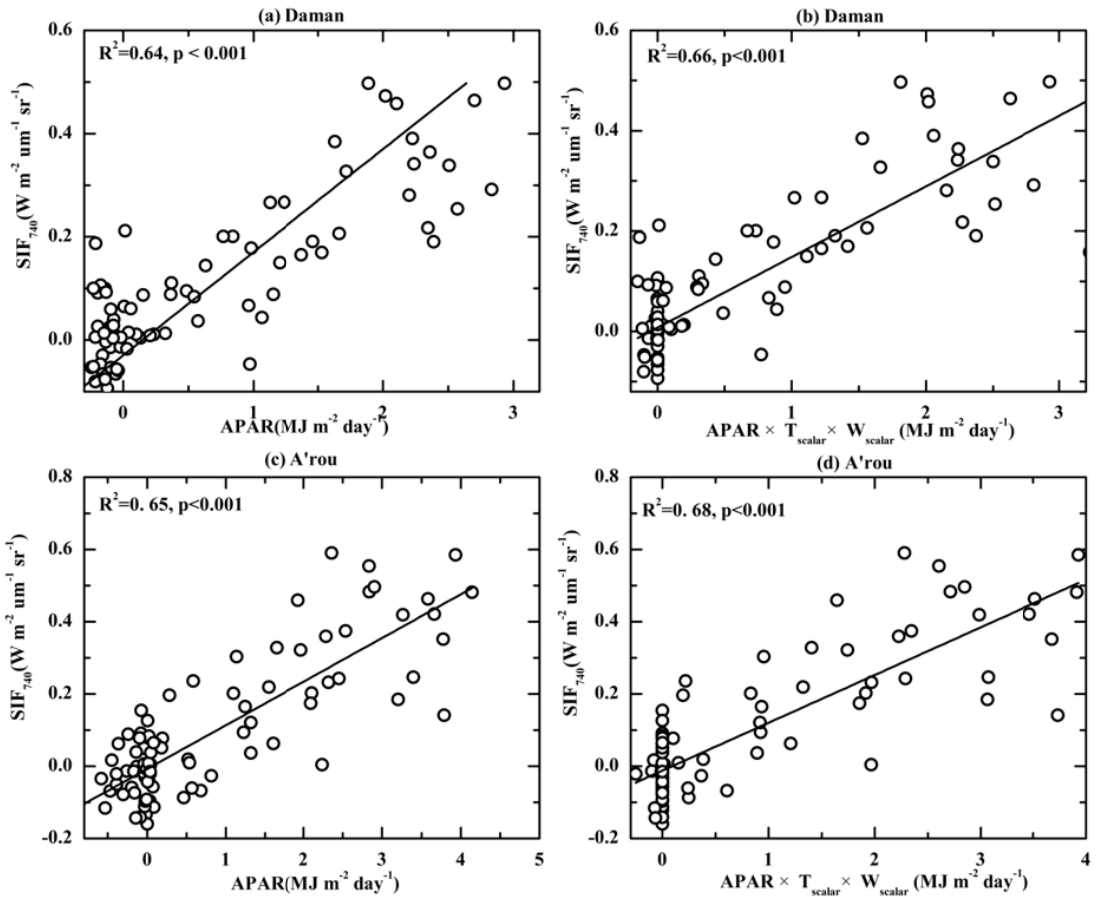
Figure 10. Relationships of GOME-2 SIF with APAR and the product of APAR with two environmental scalars (APAR × T scalar × W scalar ) at a 16-d averaged timescale: ( a ) GOME-2 SIF versus APAR at the Daman site; ( b ) GOME-2 SIF versus APAR with two environmental scalars at the Daman site; ( c ) GOME-2 SIF versus APAR at the A’rou site; ( d ) GOME-2 SIF versus APAR with two environmental scalars at the A’rou site.